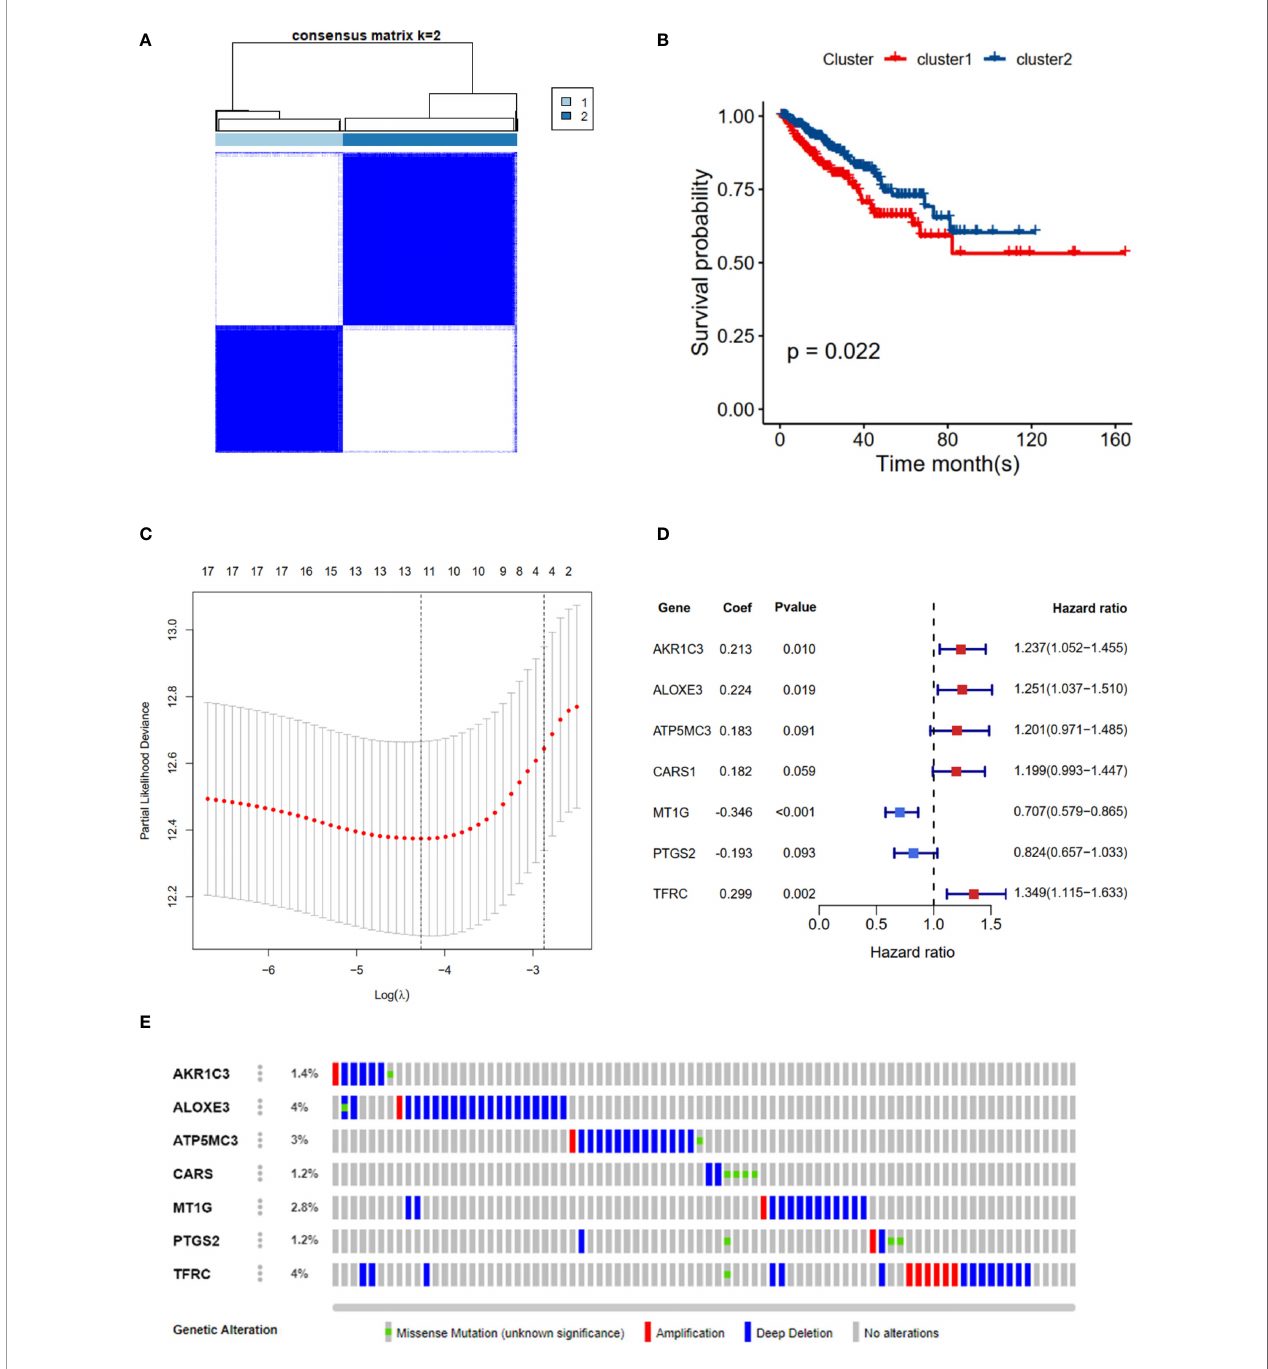
FIGURE 2 | RFS of PRAD patients in cluster 1/2 subgroups and risk signature with 7 FRGs. (A) Consensus Clustering matrix for k =2. (B) Kaplan-Meier curves of DFS. (C) The Cross-Validation fi t curve calculated by lasso regression method. (D) The coef fi cients of seven hub FRGs estimated by multivariate Cox regression. (E) Genetic alterations of seven hub FRGs. All the survival analysis are based on the recurrence free survival